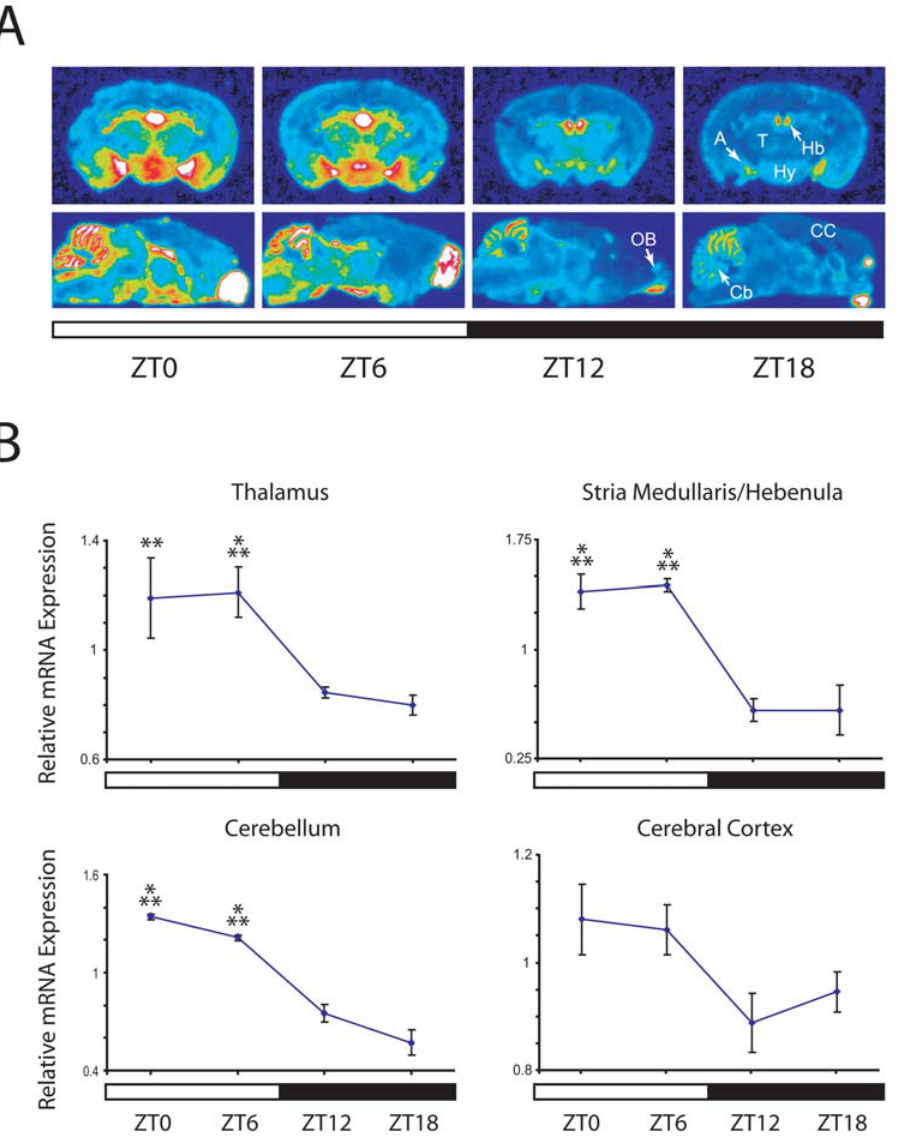
Figure 2. Fabp7 mRNA changes globally during the diurnal period. A) Coronal (top series) and sagittal (bottom series) sections from four diurnal time points subjected to in situ hybridization using 35 S-labeled Fabp7 antisense riboprobe. Note more intense expression levels during lights- on. B) Graphic representation of relative Fabp7 mRNA expression at four time points. A statistically significant diurnal variation in expression was observed; Two-way ANOVA (p , 0.001). ***p , 0.001, **p , 0.01 versus ZT18 (post-hoc Bonferroni). Each value represents the average + / 2 S.E.M. N =2– 5 per time point. A, Amygdala; Cb, cerebellum; CC, cerebral cortex; Hb, medullaris/hebenula; Hy, hypothalamus; OB, olfactory bulb; T, thalamus